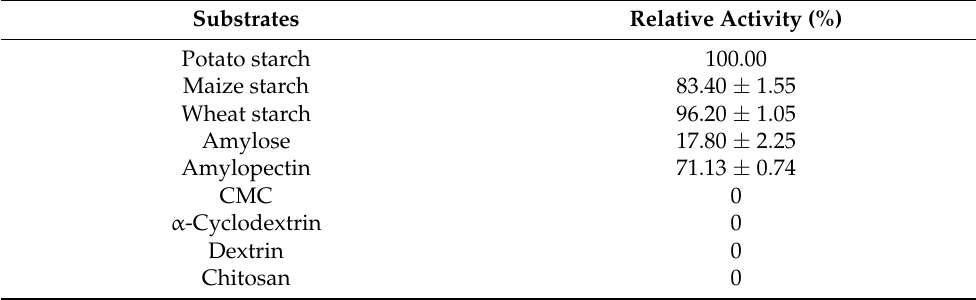
Table 4. Relative activities of purified BCA on various substrates